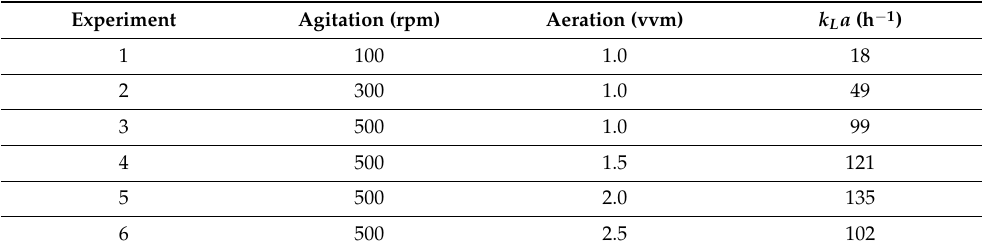
Table 1. Agitation (rpm), aeration (vvm) conditions, and experimental results of the